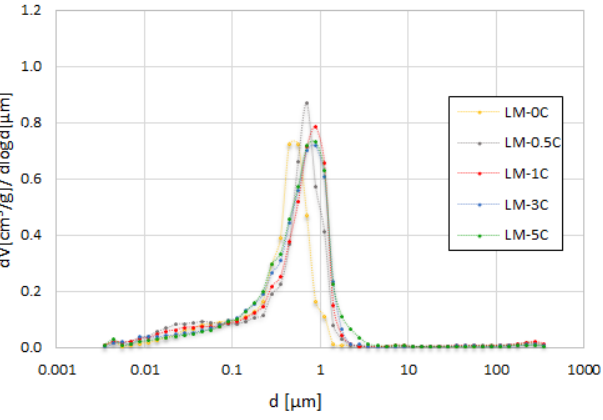
Figure 4. Differential volume of intruded mercury versus pore diameter for tested lime-metakaolin pastes.